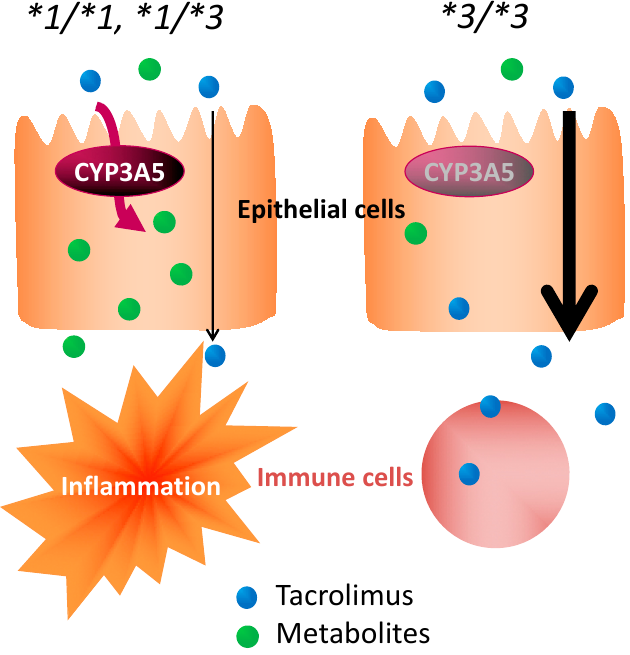
Figure 6. Impact of CYP3A5 genotype in the pharmacological effect of tacrolimus in colon epithelial cells.